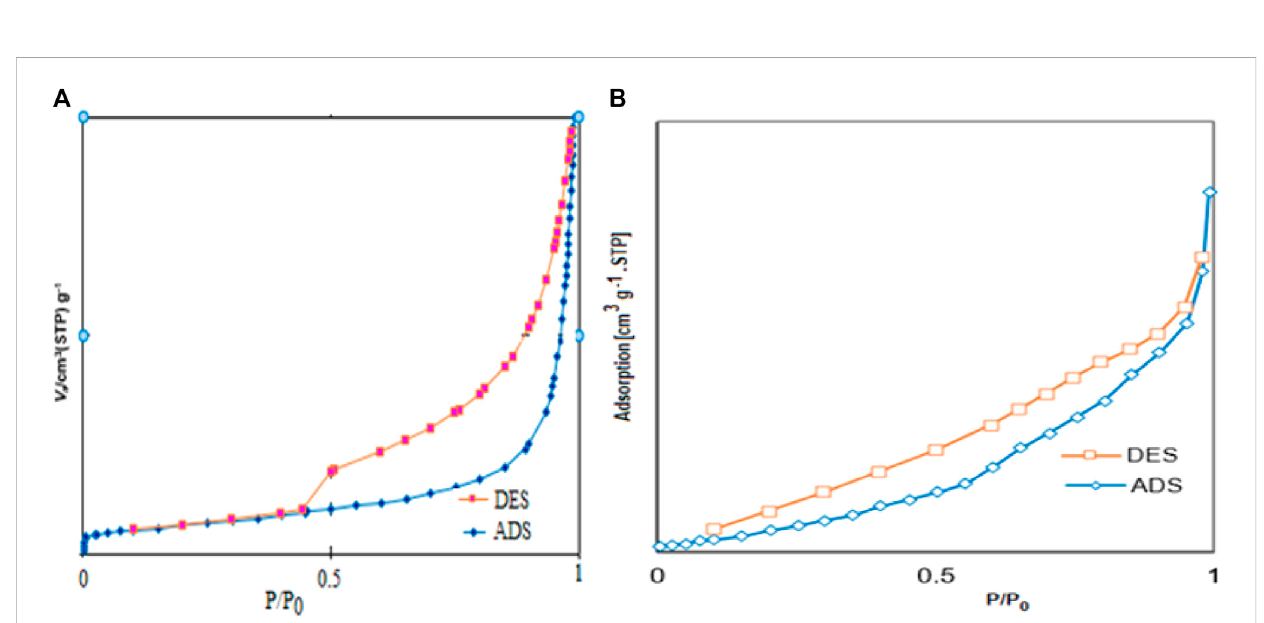
FIGURE 6 Nitrogen adsorption – desorption isotherms of (A) GO and (B) Cu-PTC@GO.